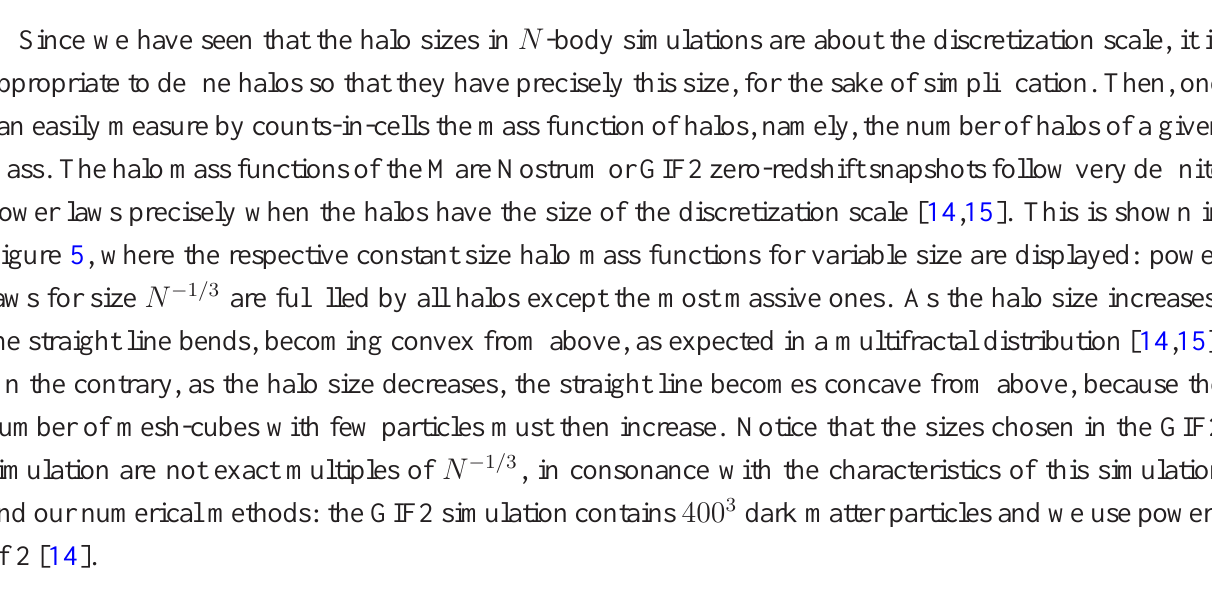
Figure 5. Constant size halo mass functions for variable size λ , for the Mare Nostrum, above, and GIF2, below, z = 0 snapshots. Abscissas: halo mass; ordinates: number of